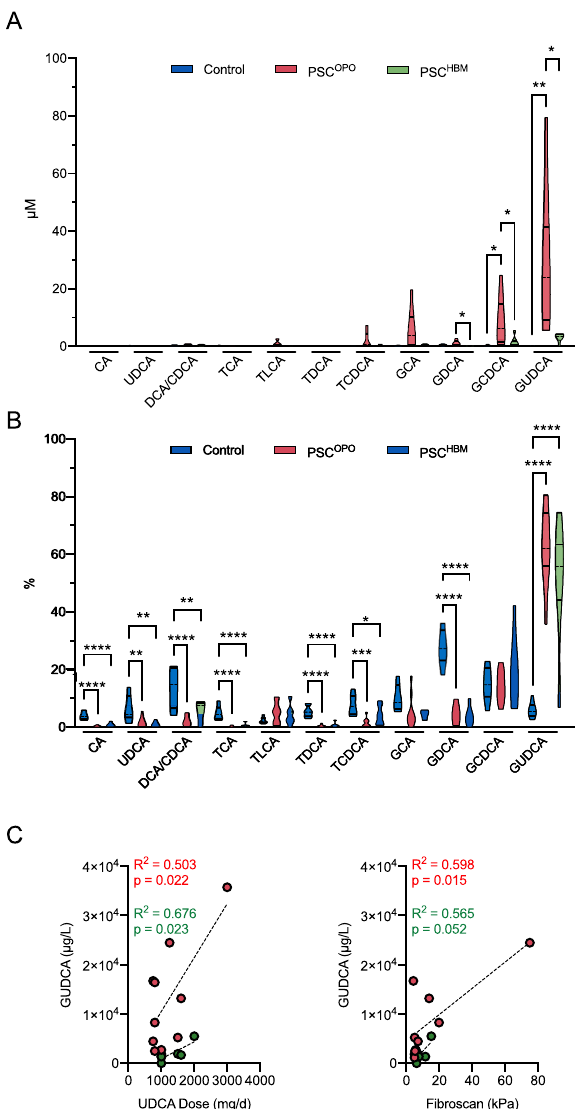
Figure 2. Bile acid concentrations in the serum of PSC OPO and PSC HBM patients. ( A ) Concentrations of unconjungated and conjugated bile acids were measured in the serum of control individuals and of PSC OPO and PSC HBM patients. ( B ) Shown is the percentage of the indicated bile acids when related to the total bile acid pool. ( C ) Linear regression analyses were performed to investigate the association of UDCA dosage with GUDCA levels (left) and of Fibroscan values with GUDCA levels (right). Data were analyzed by one way ANOVA with Tukey’s multiple comparison test and linear regression model. * p < 0.05, ** p < 0.01, *** p < 0.001, **** p <